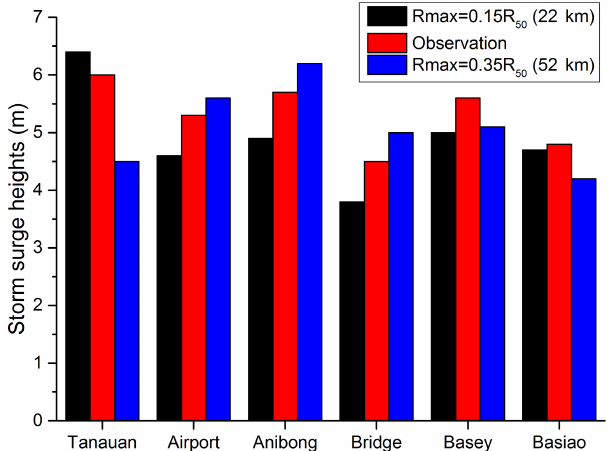
Figure 9. Maximum storm surge heights in San Pedro Bay due to the passage of Typhoon Haiyan (after Takagi et al., 2015a). Figure 10. Simulated storm surge heights (black and blue) derived from different maximum wind radii ( R max ) and observed storm surge heights (red).